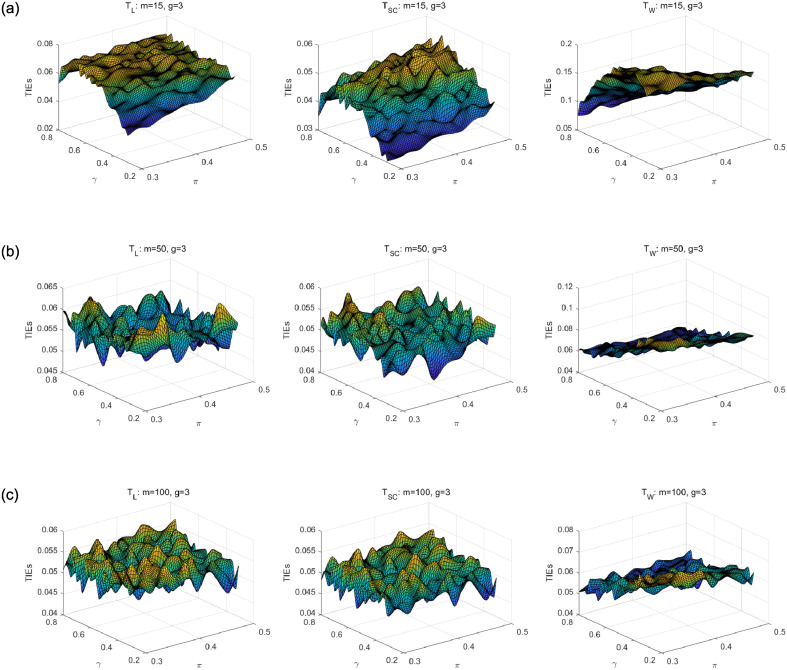
Empirical TIE surfaces of asymptotic tests for g = 3, πi = π and γi = γ.